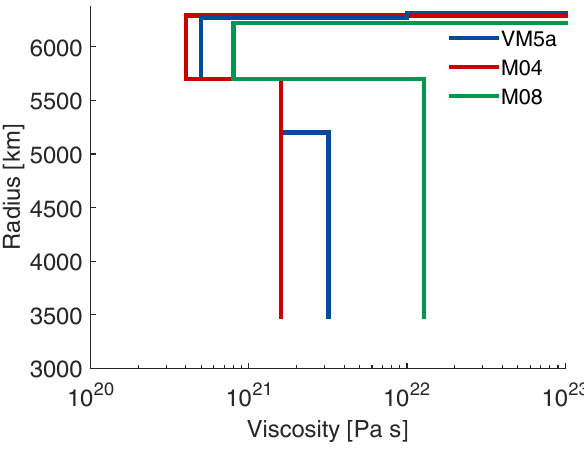
Figure 1. The three viscosity profiles used in this study. M04 refers to viscosity profile M4-16-80, and M08 refers to M8-128-150.